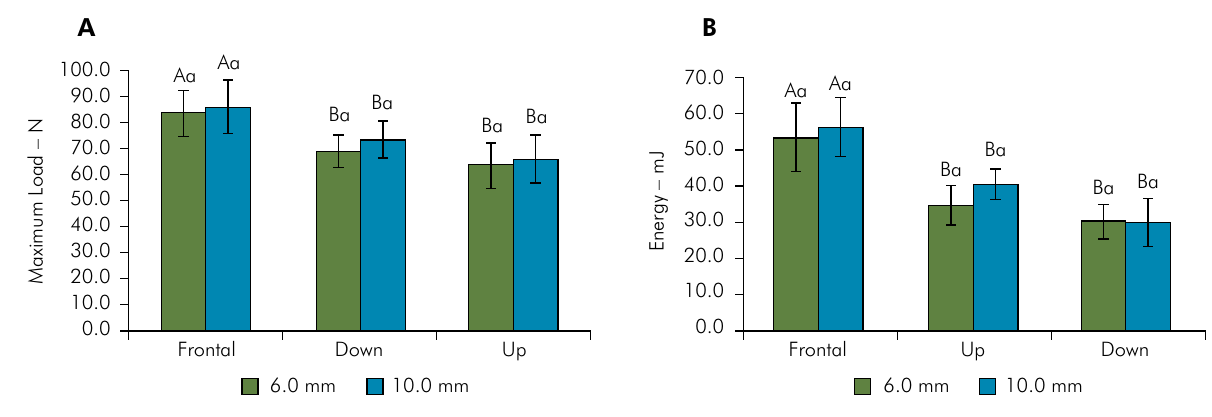
Figure 3. A. Maximum force (N), B. Stiffness (N/mm) determined experimentally by three-point bending test with the rat tibia (n = 10) with the defect positioned downward, frontal or upward and span distances of 6.0 and 10.0